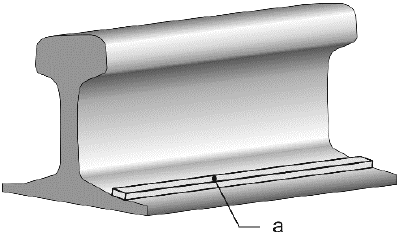
Figure 1. Location of a resistance heater “a” along a rail foot.